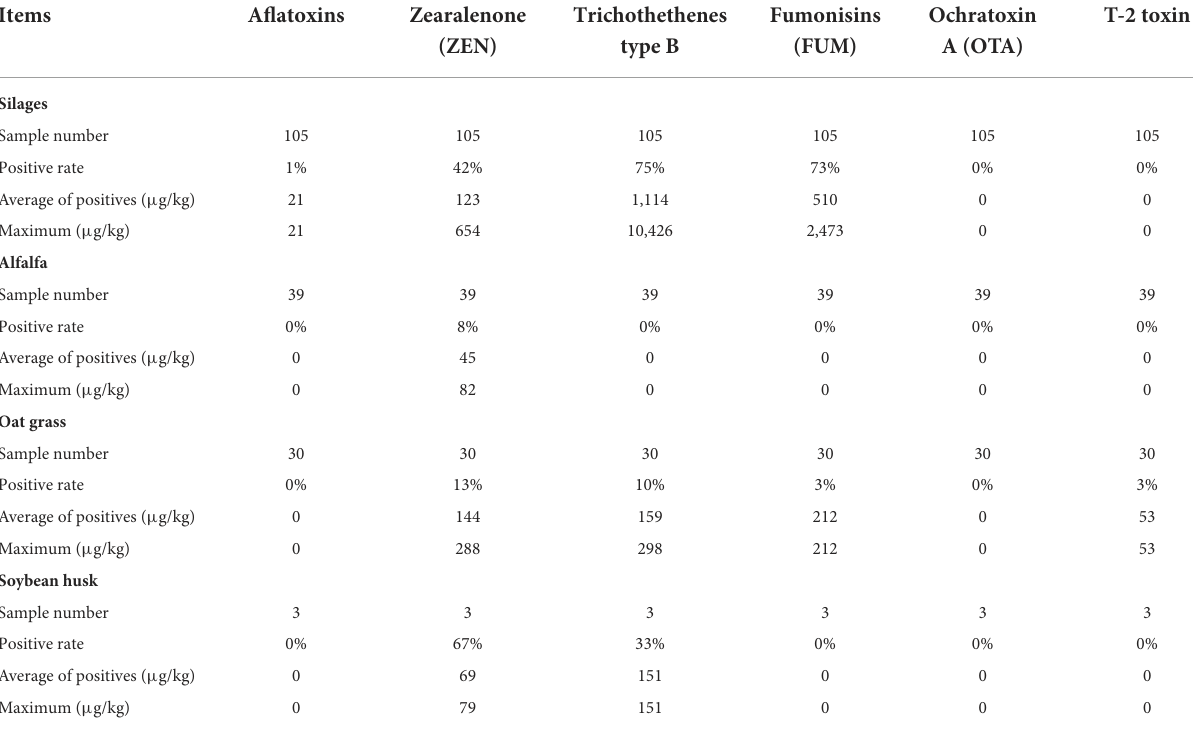
TABLE 4 Mycotoxin occurrence in